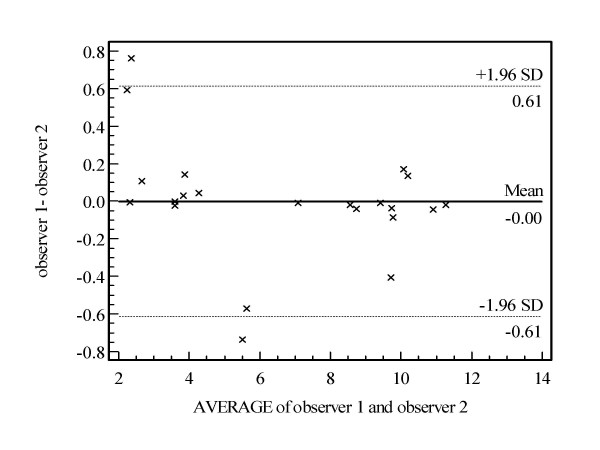
Bland-Altman Plot of interobserver repeatability of AA score between observer 1 and observer 2